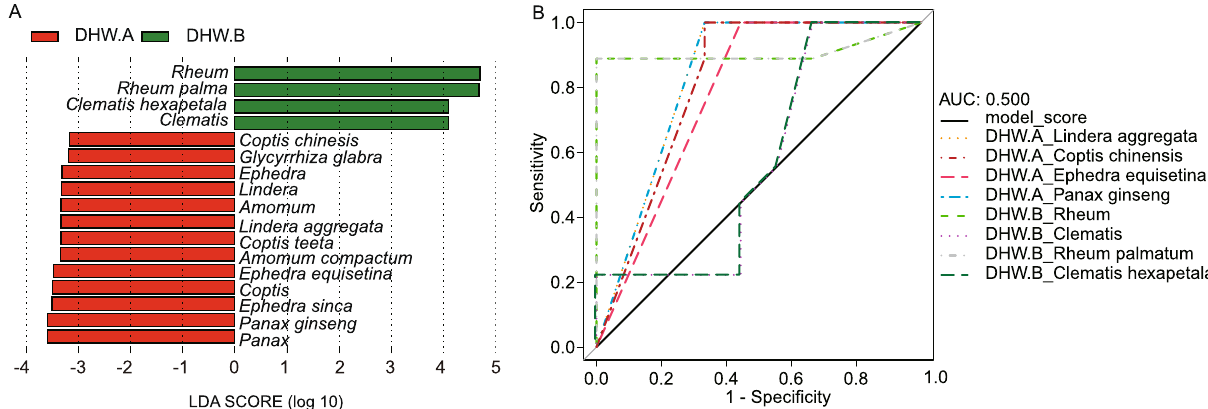
Figure 6. The difference of samples from the two manufacturers ( A , B ) could be driven by a few discriminative prescribed herbal species of DHW using ITS2 biomarker. ( A ) The legacy biomarkers selected by LEfSe; ( B ) ROC curves to visualize the MEI score of the legacy biomarkers after removing redundant markers from the two manufacturers.